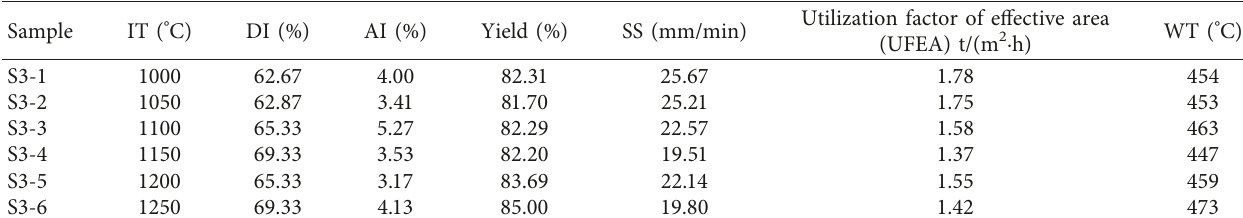
Table 11: Technical indices of the sintering process at different ignition temperatures.